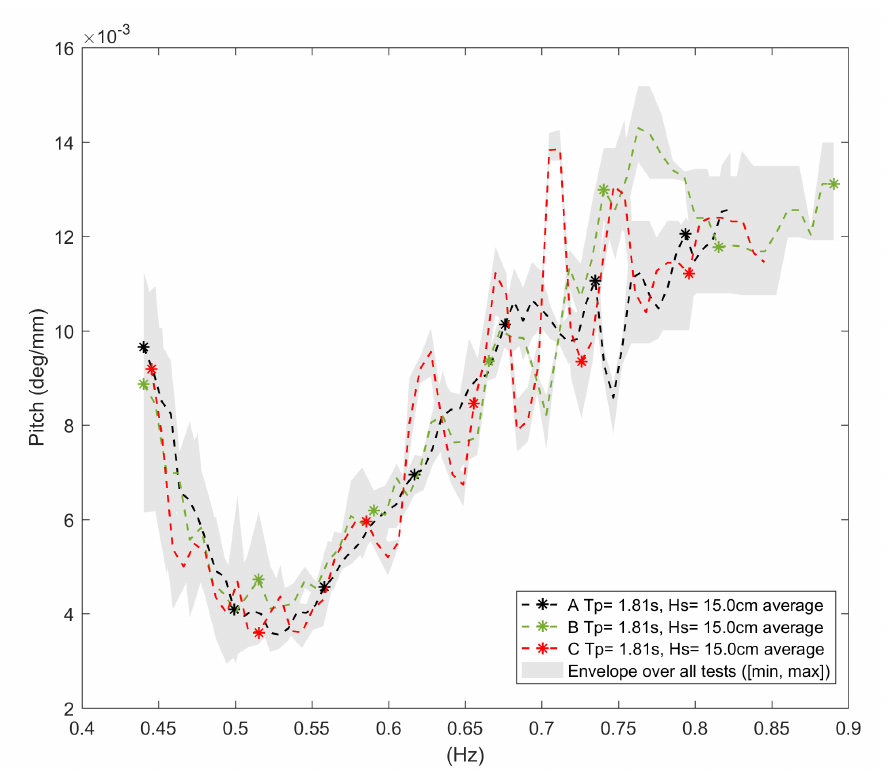
Figure 14. Pitch RAOs for all JONSWAP T p = 1.81 s H s = 15 cm waves with distinct